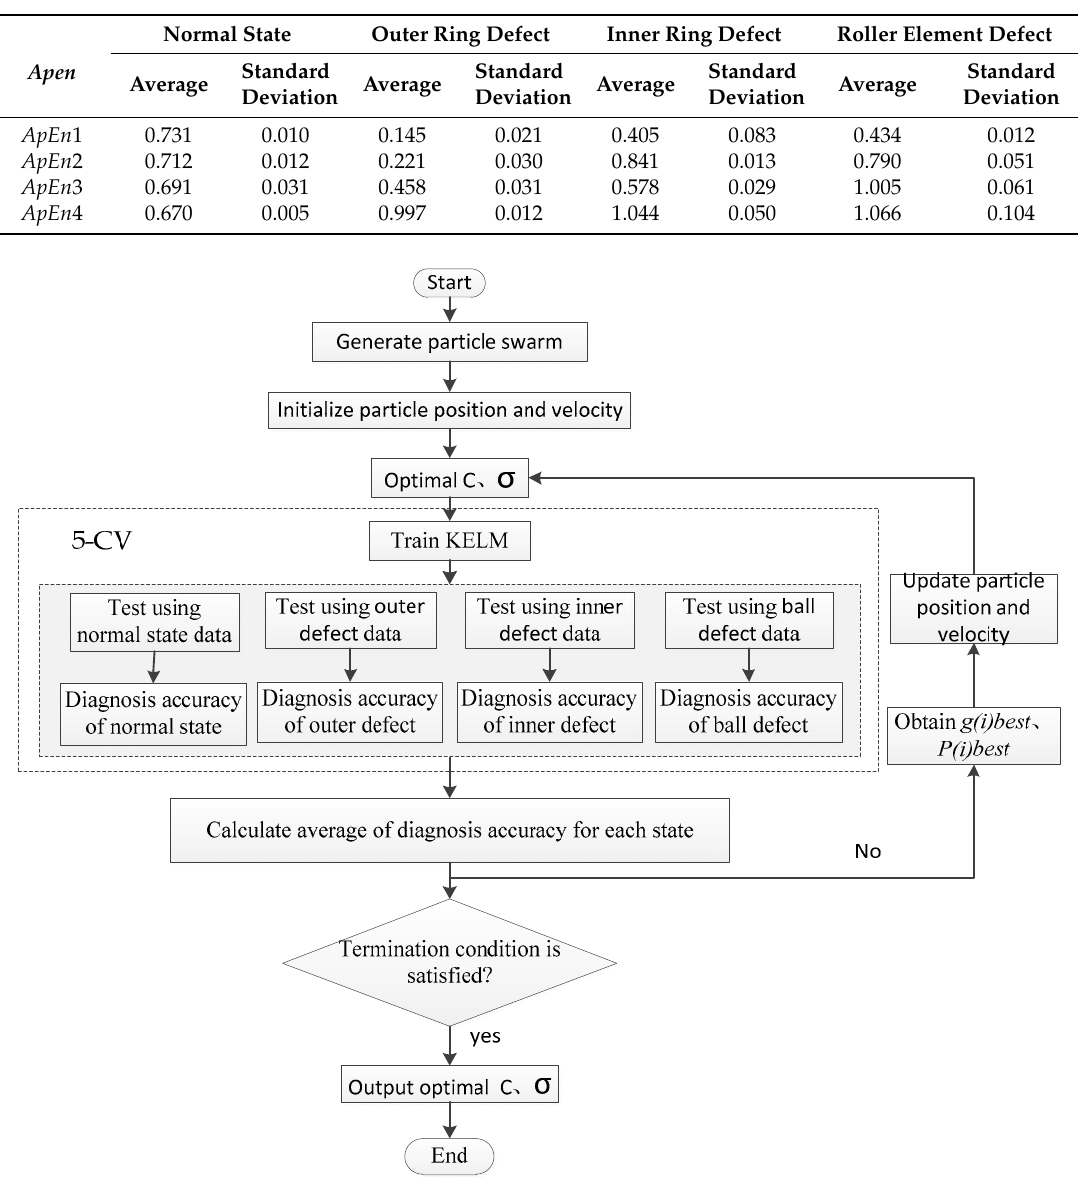
Figure 14. PSO-KELM (particle swarm optimization-kernel extreme learning machine) algorithm procedure.